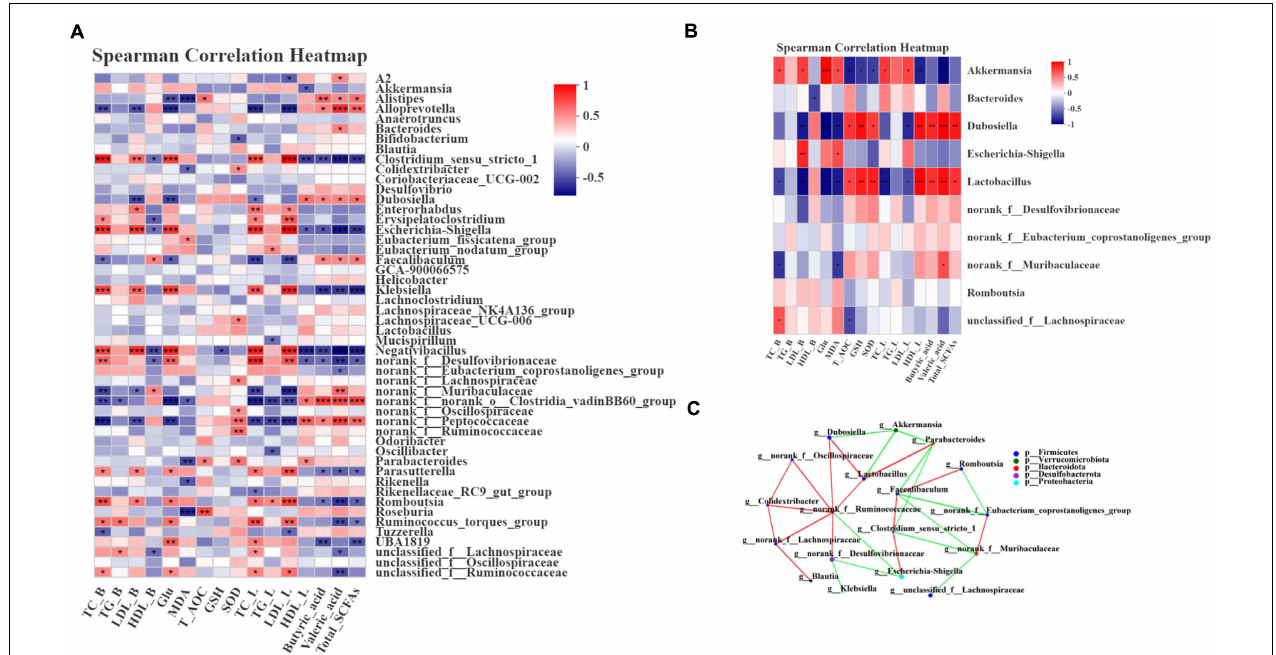
FIGURE 6 | Spearman correlation between key phylotypes, their relative abundance, and biochemical parameters. (A) Correlation between phylotypes and biochemical parameters of samples from the NC, HFD, PGLT and HFLRB groups; (B) correlation between the HFD and HFLRB groups. P values for the correlations are calculated: * represents P < 0.05, ** represents P < 0.01, *** represents P < 0.001. A positive correlation is labeled in red, and a negative correlation is labeled in blue. (C) Cooccurrence network analysis of the 18 most abundant genera deduced from two groups of diabetic and FLRB-treated diabetic mice. The size of the nodes indicates the number of phylotypes. The lines connecting each node represent the Spearman correlation coefficient values that were above 0.4 (red) or below –0.4 (green).